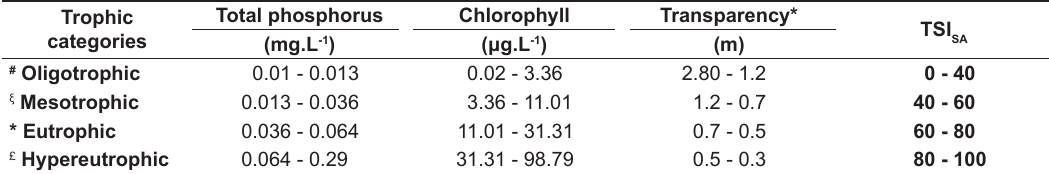
Table 3. TSI matrix and equivalence with phosphorus, chlorophyll-a and transparency in reservoirs. SA Trophic